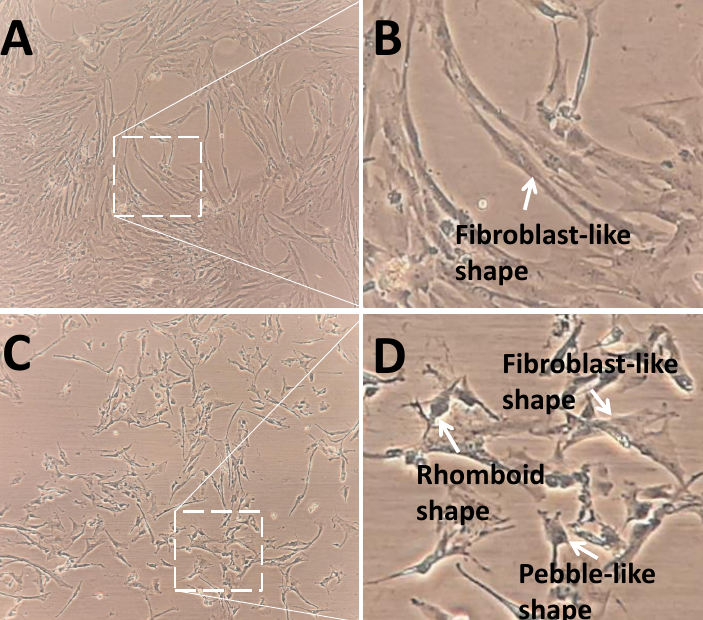
Figure 4. Morphology of pGCs. ( A , B ) pGCs from the control group showed the fibroblast-like shape; ( C , D ) pGCs from the SMG group exhibited various morphology, including fibroblast-like shape, rhomboid shape, and pebble-like shape. Original magnification × 100 ( A , C